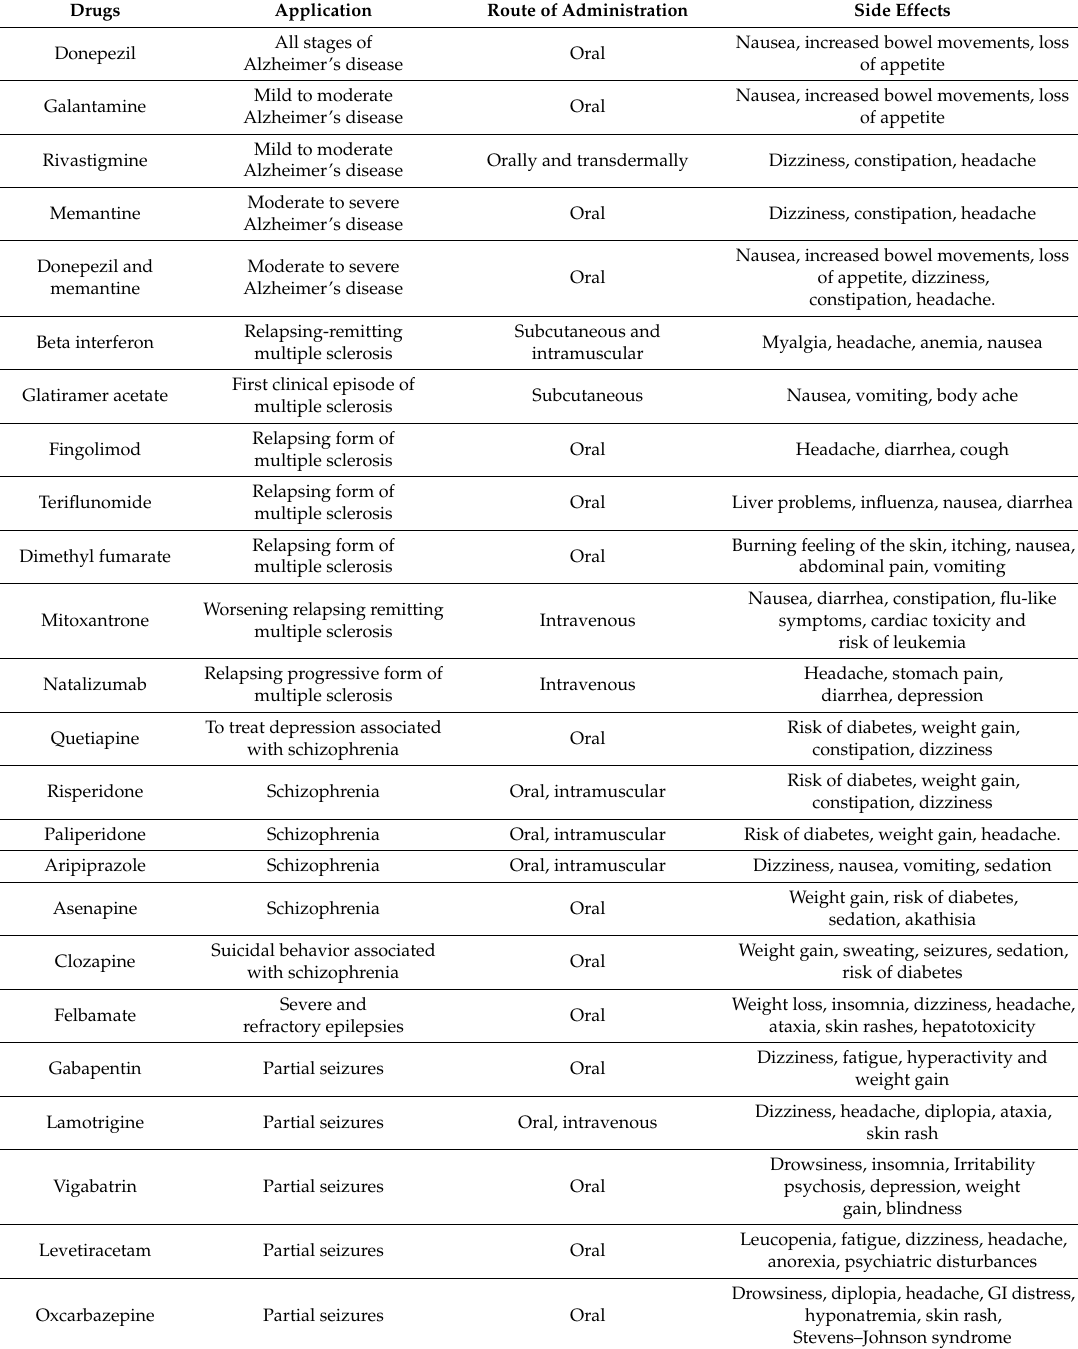
Table 1. Some drugs used for the treatment of selected neurological